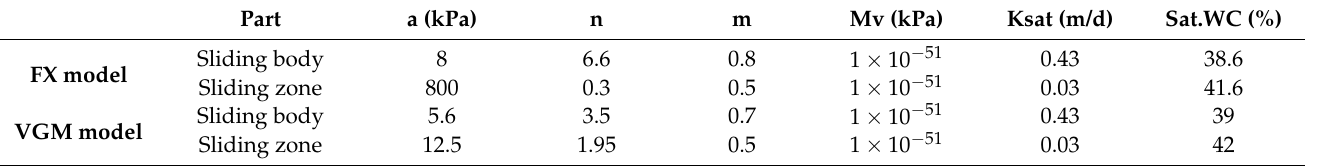
Table 4. Fredlund and Xing and Van Genuchten—Mualem model parameters of the Siwan Village landslide.